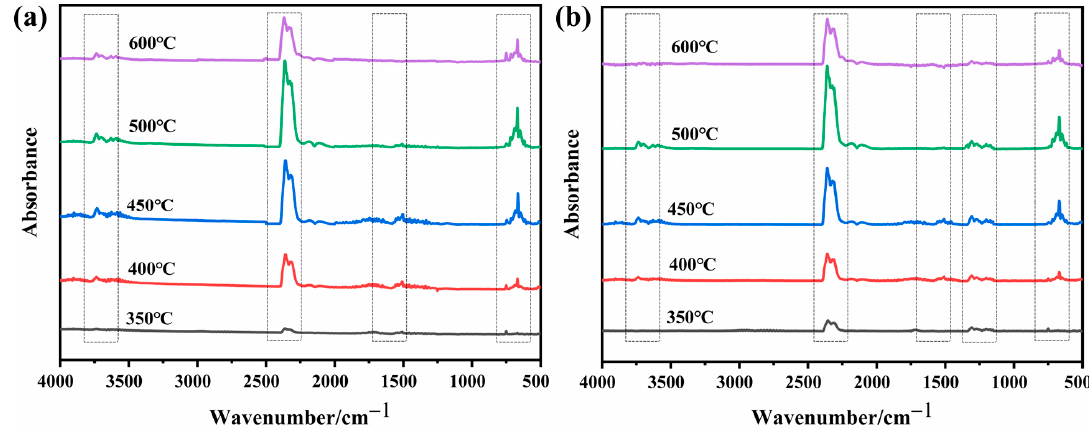
Figure 11. Three-dimensional TG-FTIR images of pyrolysis products of ( a ) PBa; ( b ) PBa/DQ-5%.